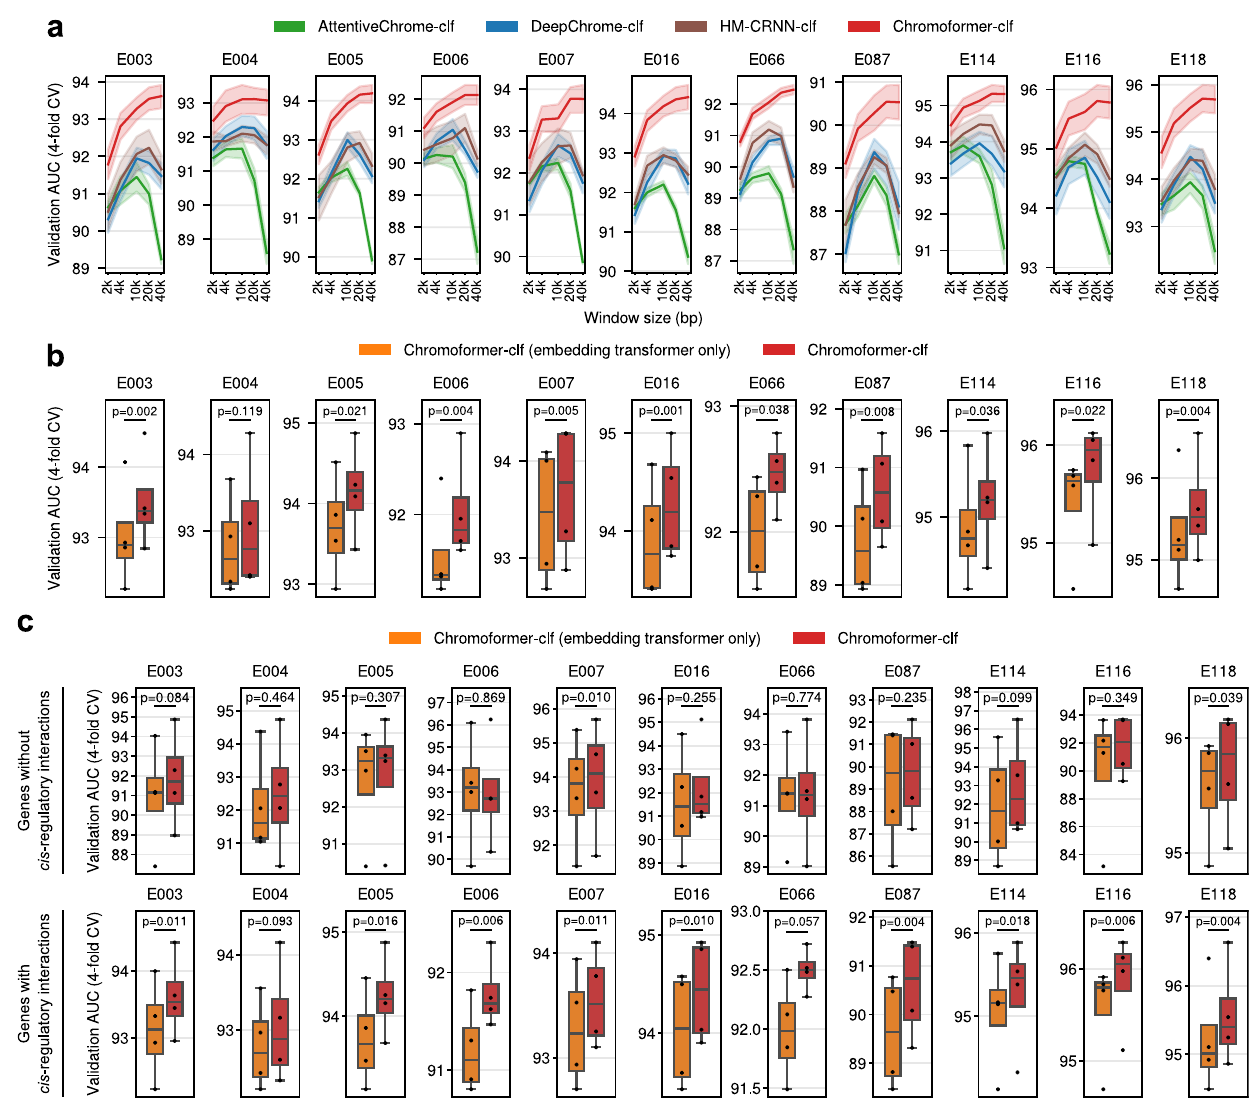
Fig. 3 | Contributing factors to the superior performance of Chromoformer. a Effect of input window size around TSS on the model performance. Chromo- former and the other benchmark models were trained for fi ve different window sizes (2kbp, 4kbp, 10kbp, 20kbp, and 40kbp), while all the other training pro- cedureswerekeptthe sameaspreviously.Boldlinesdenotetheaveragevalidation AUC across 4-fold cross-validation for each window size, while the shades denote the standard error of them. b Effect of taking distal cis -regulations by pCREs into account. We trained ablated Chromoformer models which only have the Embed- ding transformer and thus cannot incorporate the cis -regulatory information between the core promoter and pCREs. The resulting cross-validation ( n =4)